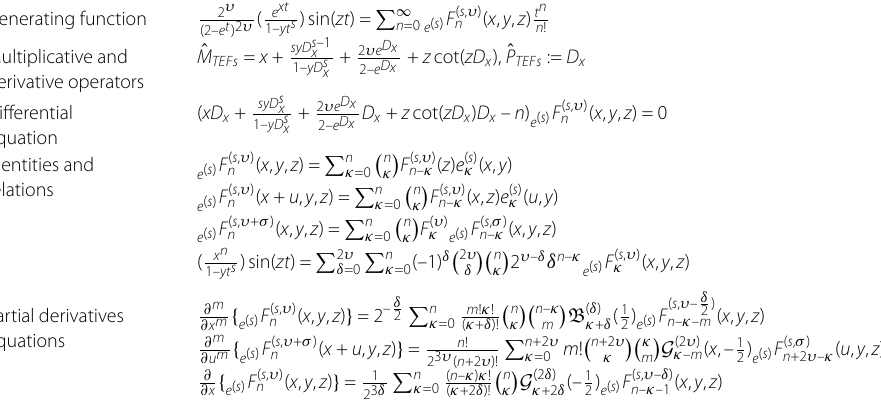
Table 7 Results for Generating